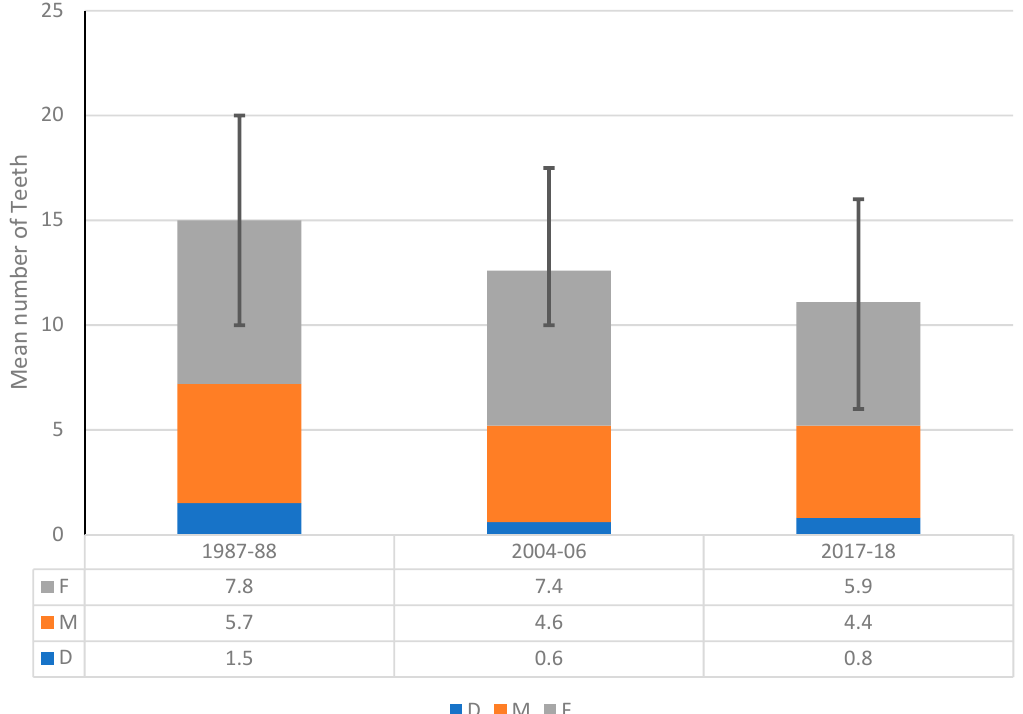
Figure 2. Trends in complete tooth loss among Australians aged 15 years and over, 1987–88, 2004–06 and 2017–18. A comparison of the proportions of Australian adults with moderate or severe peri- odontitis by age is depicted in Figure 3. The overall prevalence of periodontal disease increased from 22.9% in 2004–06 to 30.1% in 2017–18. This was reflected in a consistent